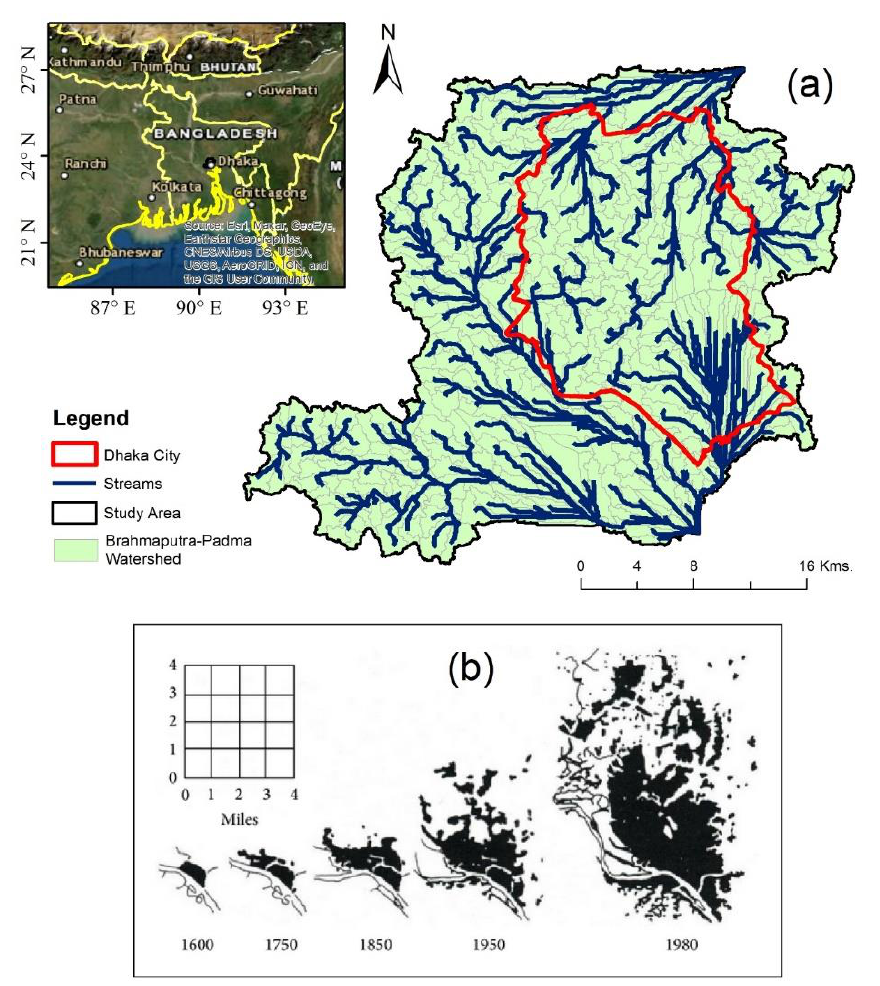
Figure 1. ( a ) study area location map; ( b ) 400 years of urban growth scenario of Dhaka city [80] . The temporal Landsat images at a decadal time interval (1978, 1988, 1998, 2007, and 2018) covering the entire watershed were used along with the Shuttle Radar Topography Mission (SRTM) 30 m digital elevation model (DEM) in the present study. The specifications of the satellite data used